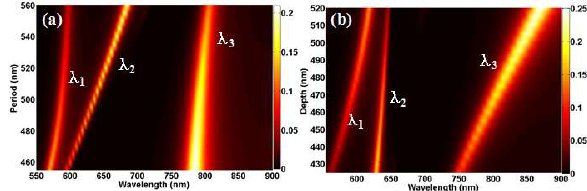
Fig. 3. Transmission intensities through a nanoslit array as a func- tion of wavelength ( λ ) and slit period (a), wavelength ( λ ) and slit depth